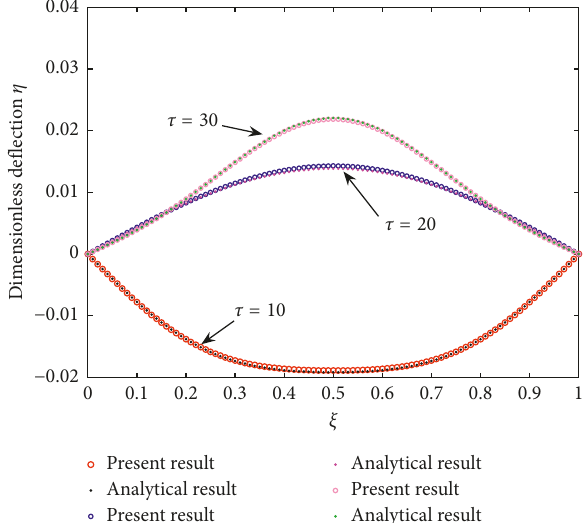
Figure 5: Comparison of deflection of the pinned-pinned pipe by two methods.